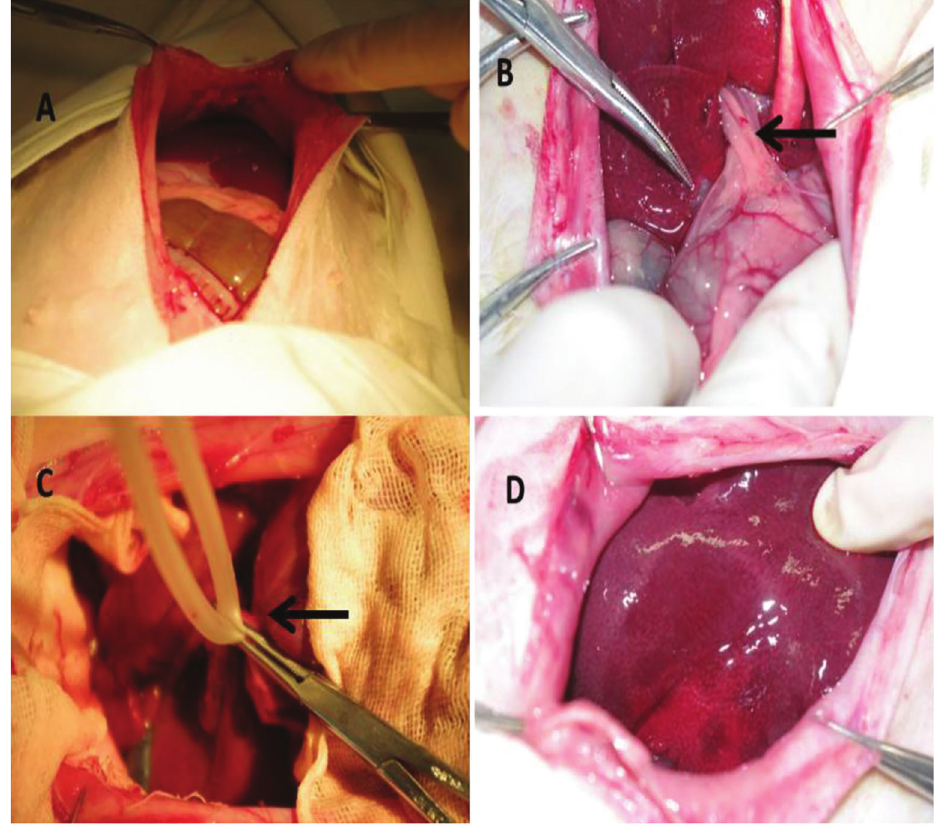
Figure 1. Pringle ’ s maneuver. A 6-cm midline incision was carried out ( A ) and the porta hepatis was exposed ( B ). The hepatic artery proper, common hepatic duct and hepatic portal vein were blocked using three vascular clips for 60 min ( C ) followed by 120-min reperfusion ( D